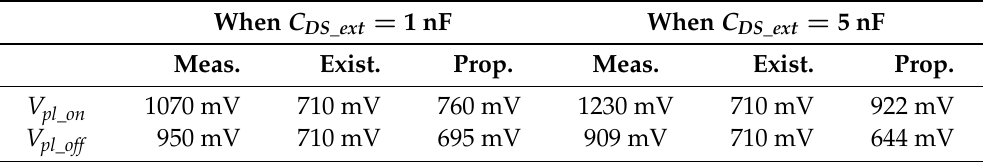
Table 2. The measured (Meas.) Miller plateau, the predicted Miller plateau by the existing (Exist.) method, and the predicted Miller plateau by the proposed (Prop.) method when the relevant capacitance changes.